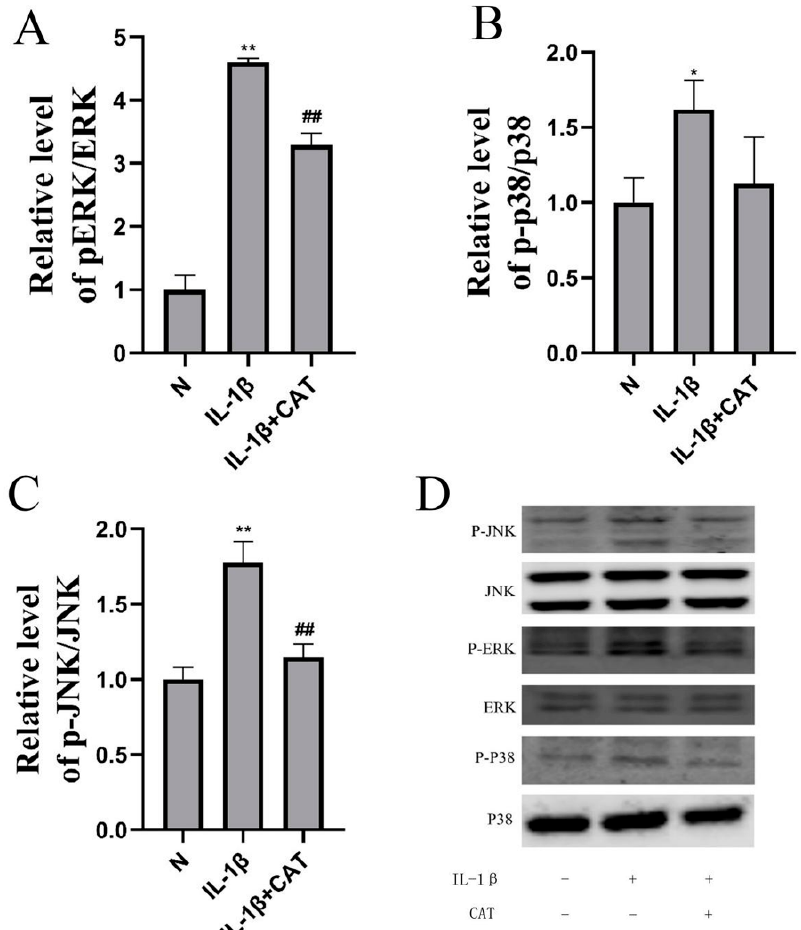
Figure 8. Catalpol inhibits activation of the MAPK pathway. ( A ) pERK/ERK level; ( B ) p-p38/p38 level; ( C ) p-JNK/JNK level; ( D ) representative images of immunoblots. The data are the mean ± S.D. of the mean (n = 3). * p < 0.05 vs. normal group (N); ** p < 0.01 vs. normal group (N); ## p < 0.01 vs. IL-1 β group.